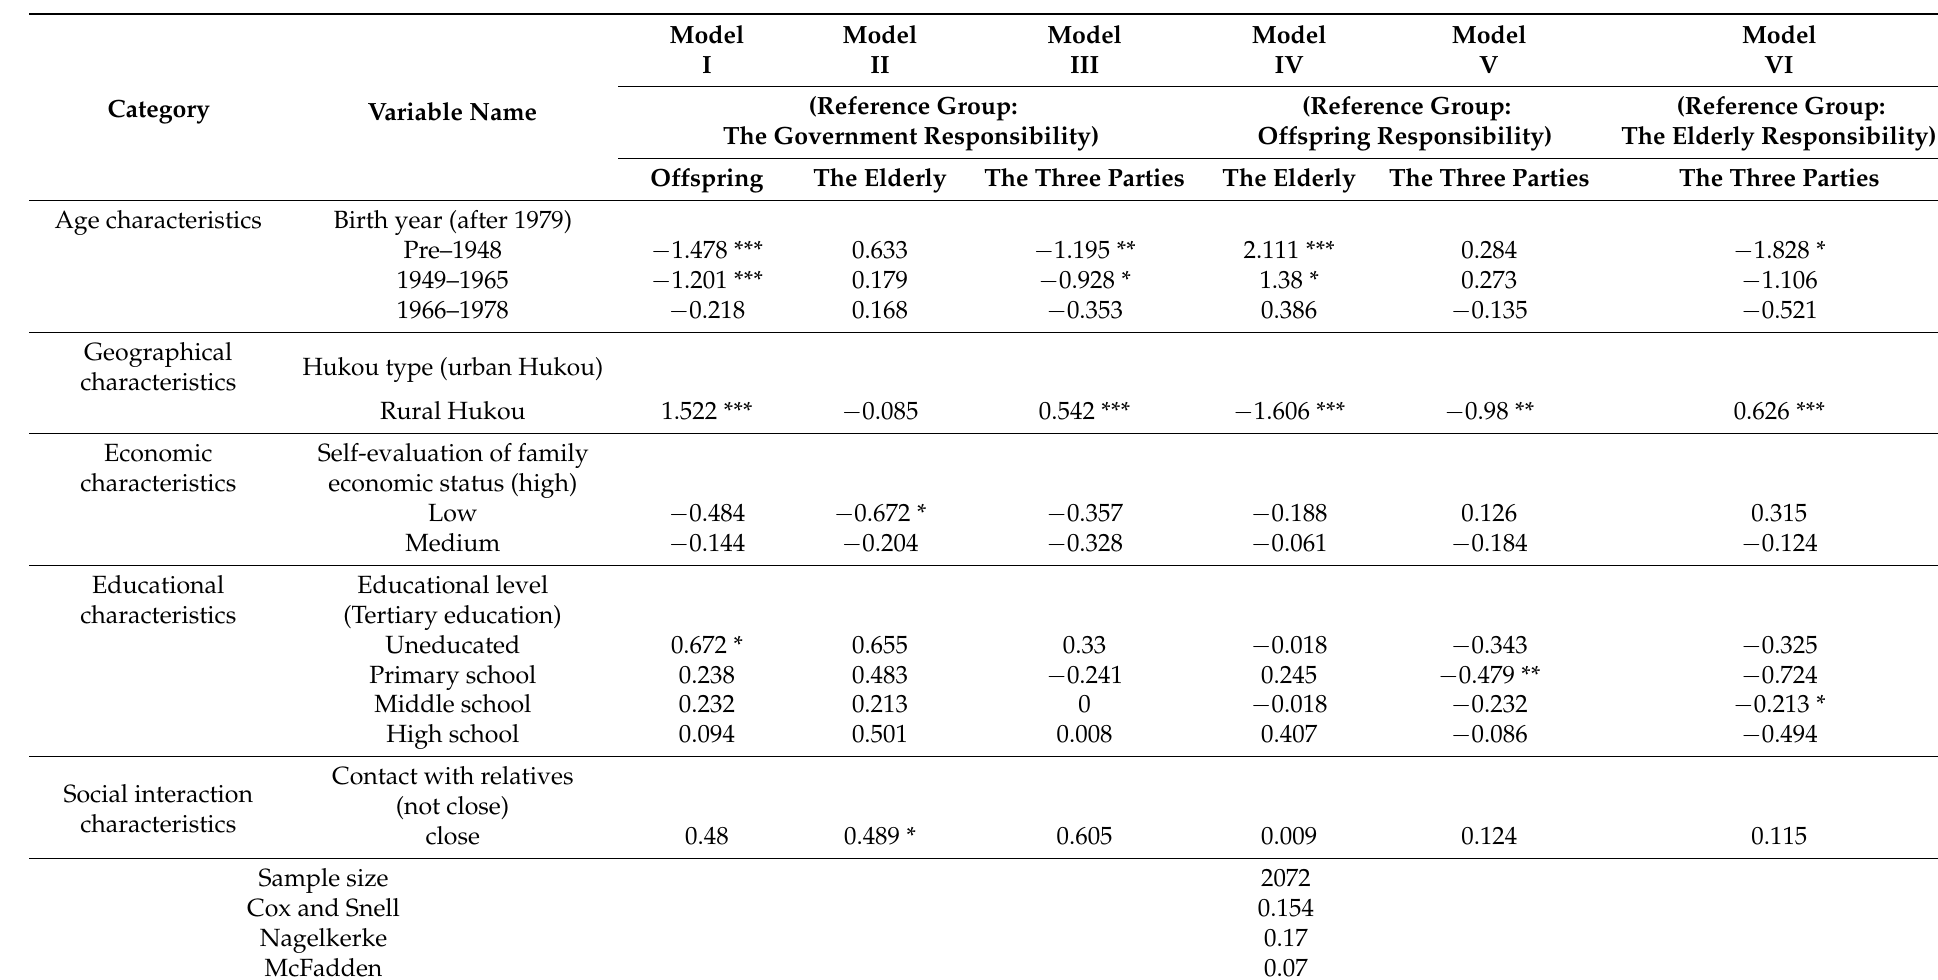
Table 4. Results of Multinomial Logistic Regression Analysis of